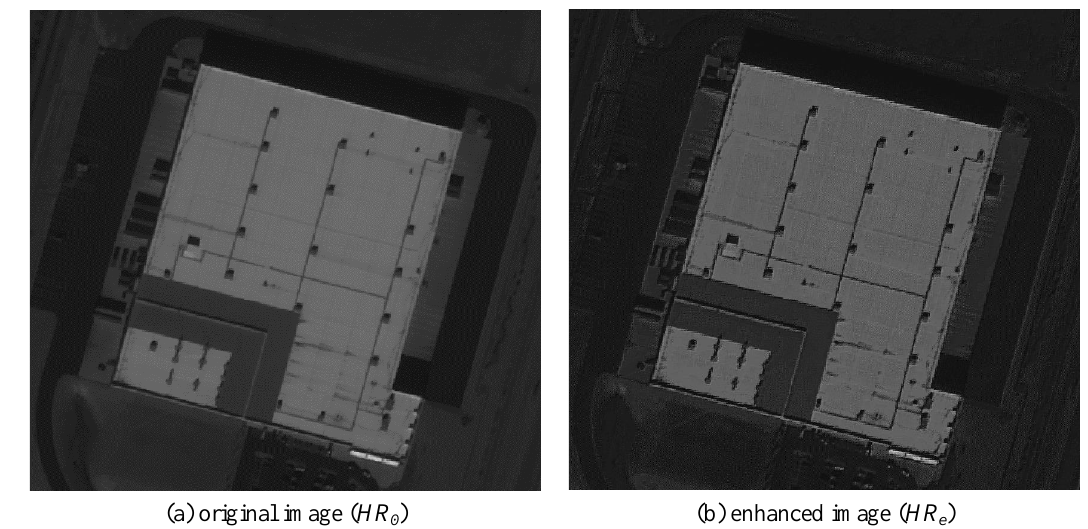
Figure 3. Comparison of high-resolution images: ( a ) original image, ( b ) enhanced image by top-hat and bottom-hat transformation.